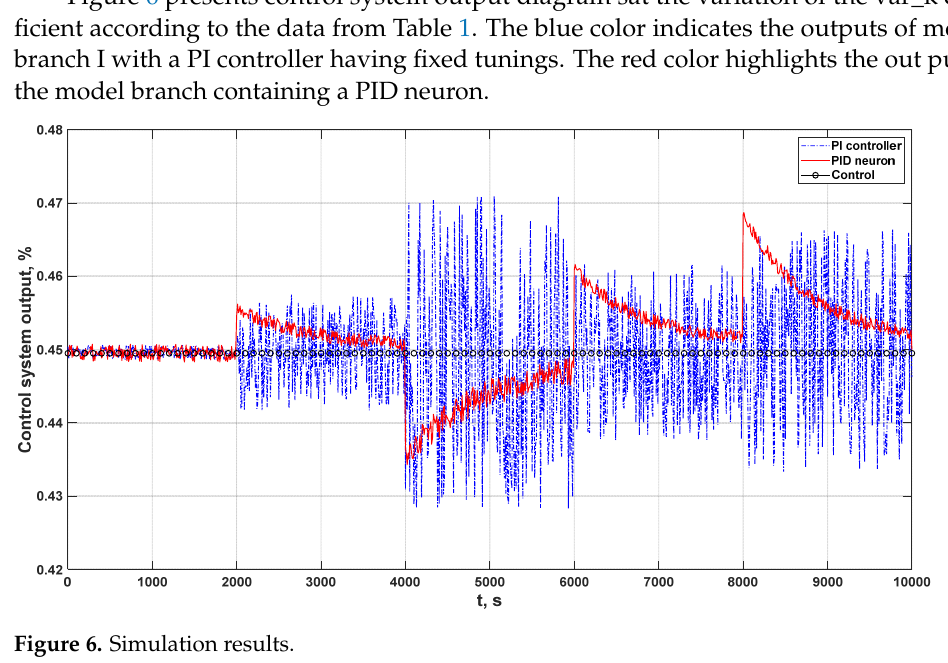
Figure 6. Simulation